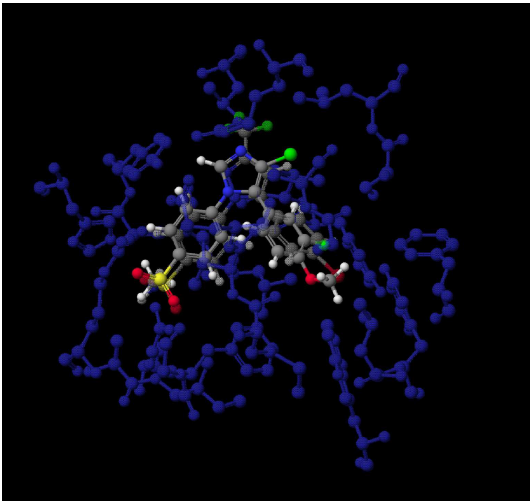
Figure 1. The docked structure of ZA18 versus SC-558 in the active site of